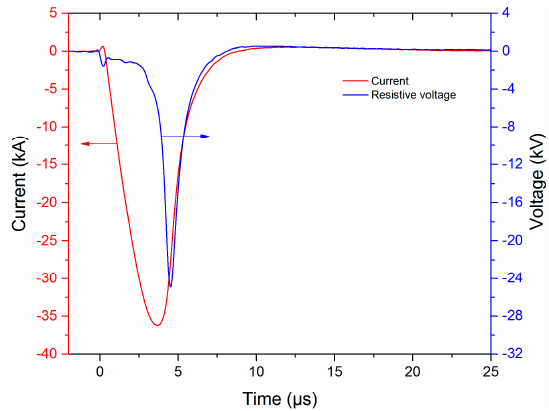
Figure 2. Typical waveforms of current and resistive voltage.